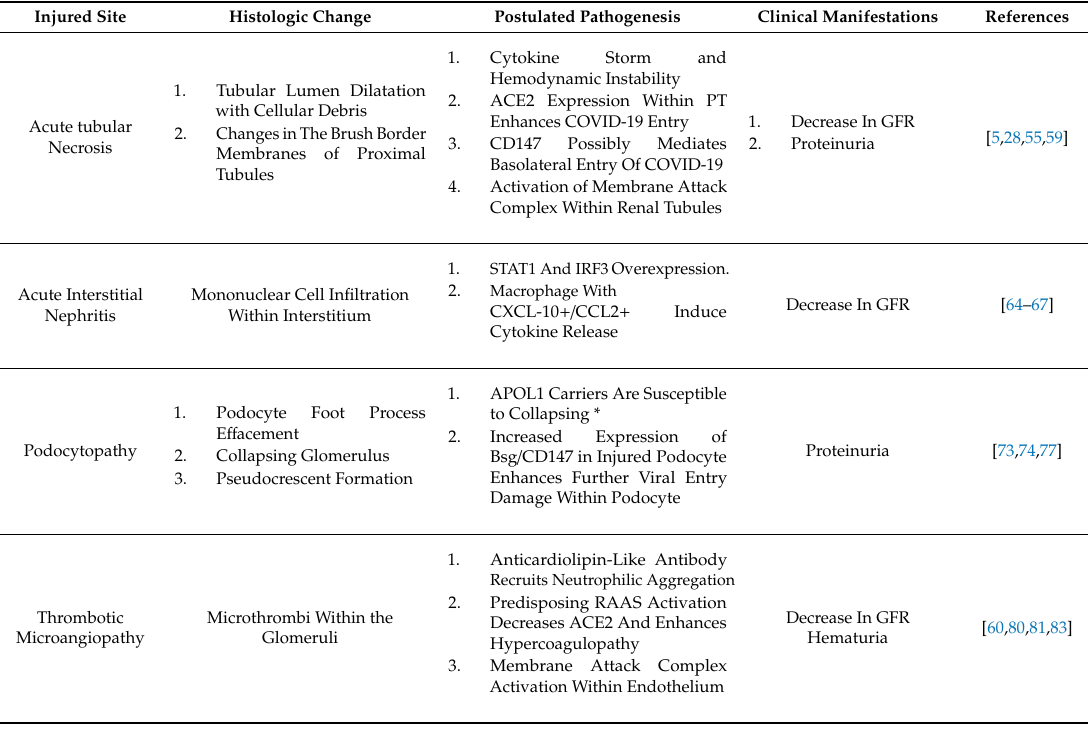
Table 1. The histopathologic and clinical characteristics of acute kidney injury in COVID-19 patients and the possible pathogenesis based on current